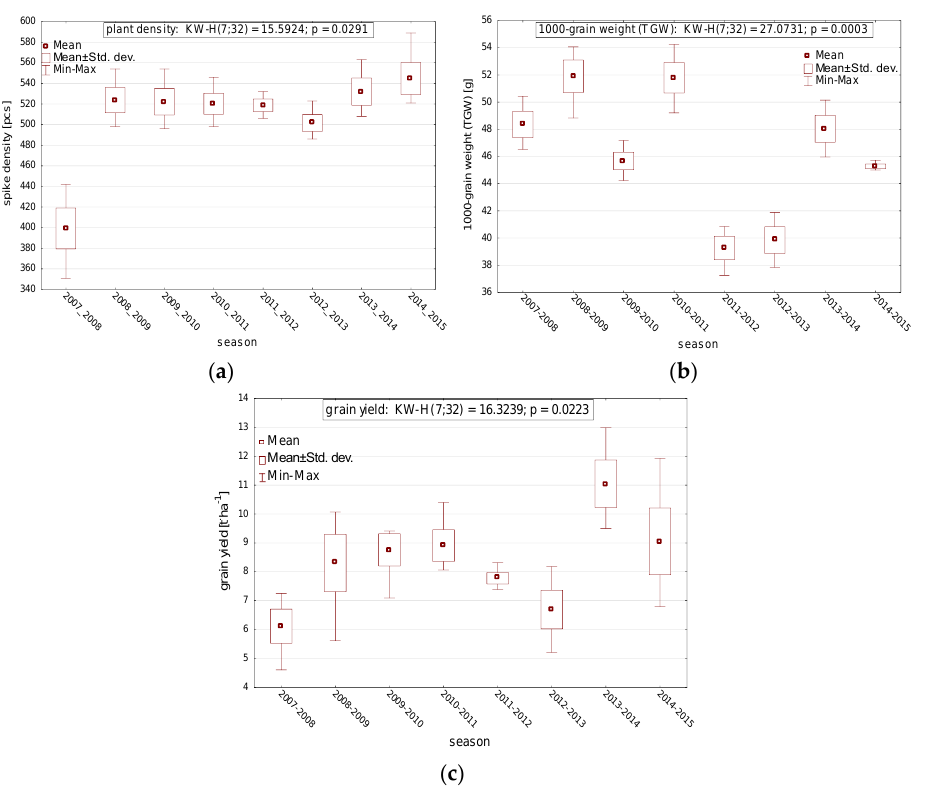
Figure 5. Basic statistical parameters of spike density ( a ), 1000-grain weight (TGW) ( b ), and grain yield in t·ha -1 ( c ) of winter wheat in the years of the study. Correlation coefficients between selected meteorological parameters (average air temperature, precipitation total, and number of days with precipitation) and the biometric parameters of winter wheat are presented in Table 3. Table 3. Correlation coefficients between biometric parameters of winter wheat and meteorological parameters.